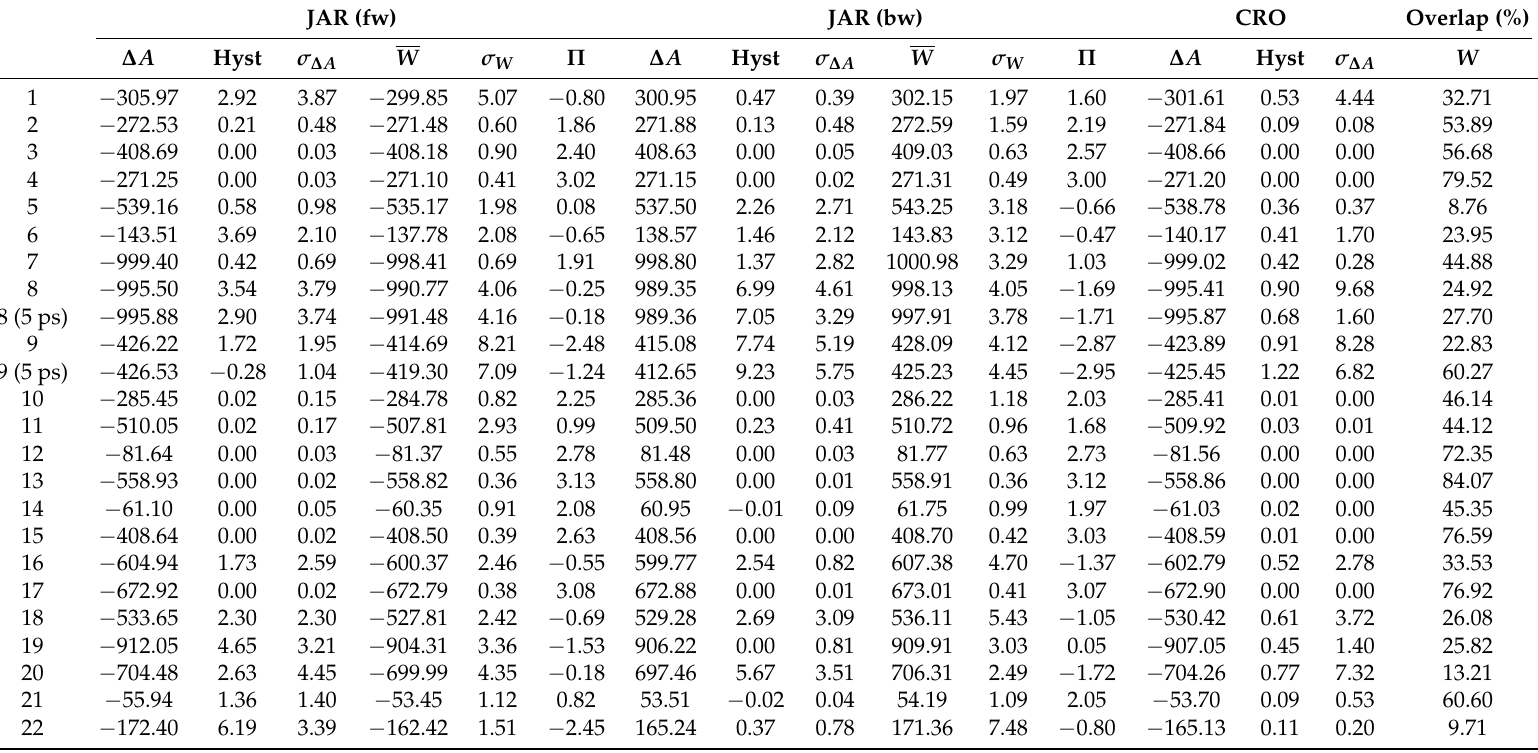
Table 3. Nonequilibrium results. ∆ A MM → 3 ob calculated with JAR (fw), JAR (bw), and CRO, as well as calculated convergence metrics. For each ∆ A , we divide the total dataset into 10 blocks, calculate ∆ A i from each of these i blocks, and compare the average of those ∆ A i to ∆ A calculated from the total dataset (giving Hyst ), and we also report the standard deviation of these ∆ A i ( σ ∆ A ). To determine the reliability of W distributions for calculating ∆ A , we report: W , the standard deviation of W ’s ( σ W ) as narrower distributions are likely to provide converged results, and finally we report one-sided Π which, when >0.5, likely indicates the W distribution is resultant from sufficient and unbiased sampling. Finally, we report percentage overlap in W between forward and backward